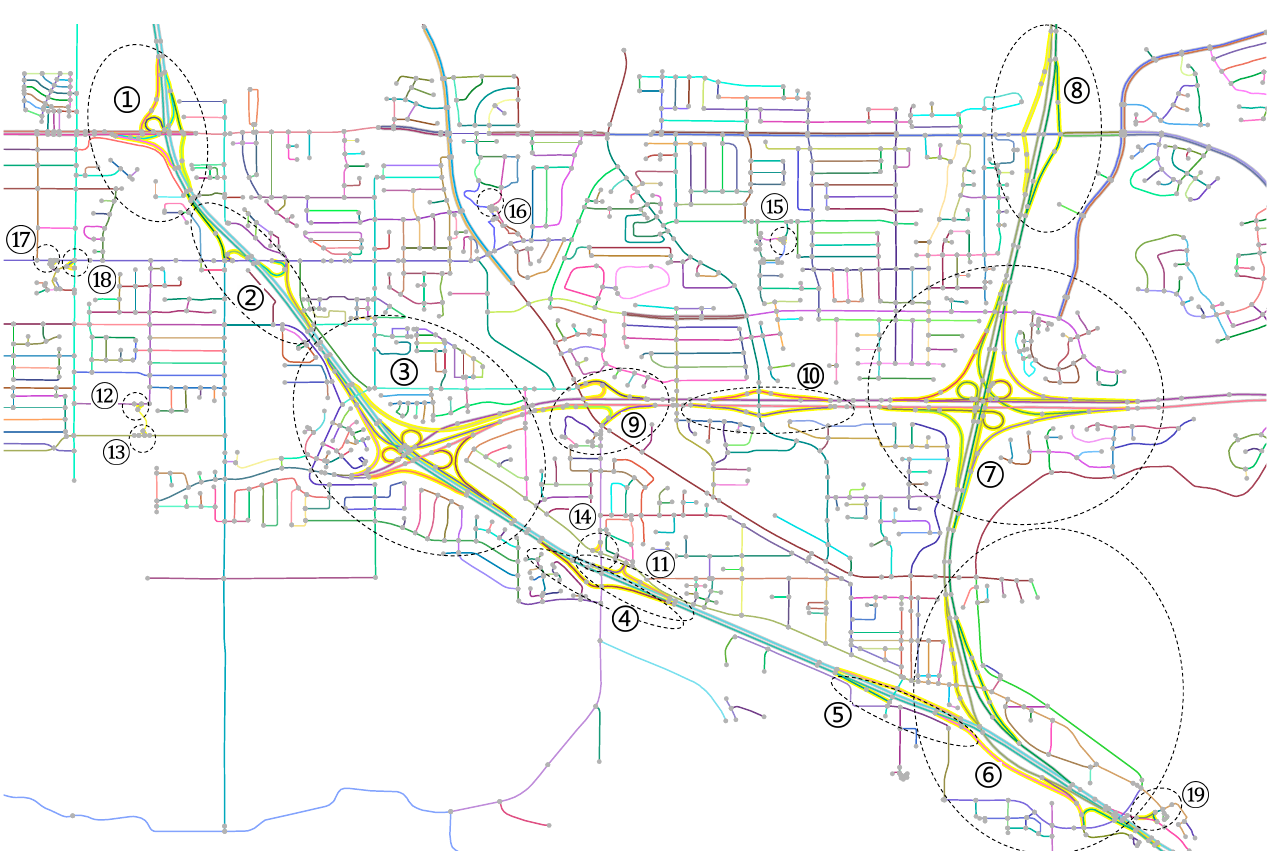
Figure 9. The test dataset and its preprocessing results after manual correction. The end points of the road segments in the raw data are represented by the light grey dots. The nineteen complex junctions to be identified are labeled from one to nineteen. The rough extents of the complex junctions are circled with the black dotted ellipses. The strokes assembled are uniquely colored using a random coloring scheme. The paired dual lines are indicated by their light grey background. The secondary roads are indicated by their yellow